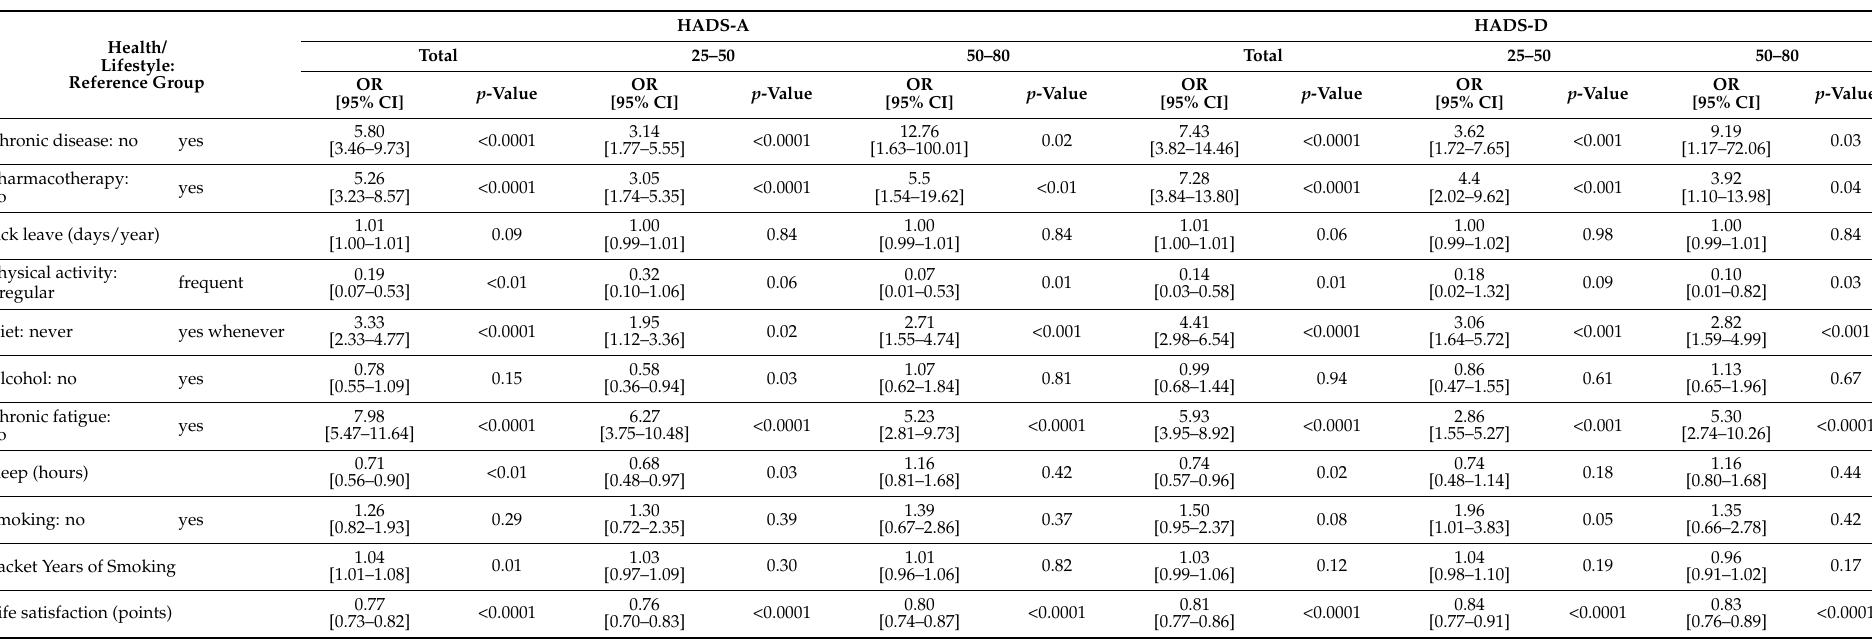
Table 4. Crude odds ratios (OR) with 95% confidence interval (CI) for the relationship between the occurrence of anxiety disorders (12 points or more on the HADS-A scale) and depression (12 points or more on the HADS-D scale) and health status or